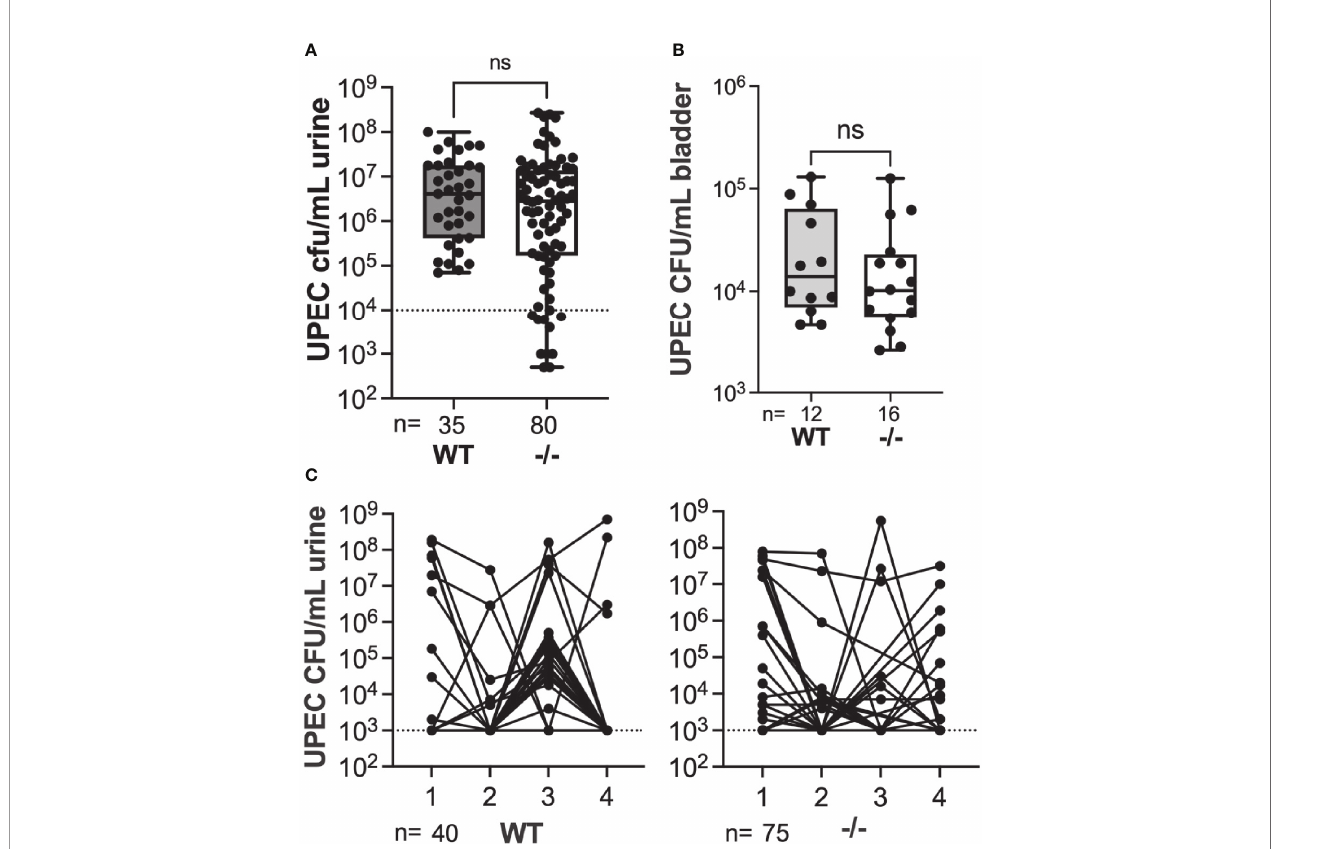
FIGURE 4 | Absence of Nur77 does not affect acute or chronic UPEC bacteriuria or bladder reservoir titers. (A) Acute UPEC bacteriuria 24 hpi following initial infection in wild type (WT) mice and mice globally lacking Nur77 (-/-). (B) UPEC titers in bladders collected 2 weeks after initial UPEC infection. All mice had cleared UPEC bacteriuria prior to bladder analysis, thus titers represent intracellular reservoirs. (C) UPEC weekly bacteriuria titers following initial UPEC infection. Each dot represents data from an individual mouse. ns, not signi fi